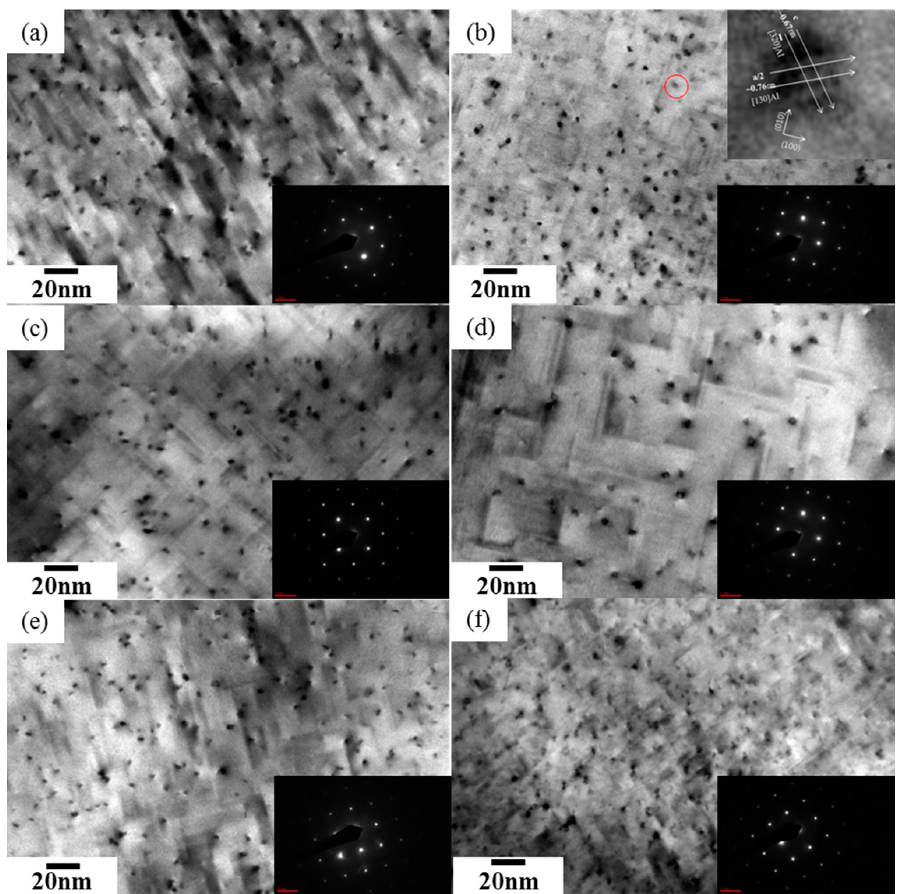
Figure 6. TEM micrographs with different heat treatments in 3M10S and 9M10S. ( a ) AA, ( c ) NA-AA, and ( e ) PA-NA-AA in 3M10S; and ( b ) AA, ( d ) NA-AA, and ( f ) PA-NA-AA in 9M10S. NA, PA, and AA stand natural aging at room temperature for 7 days, pre-aging at 100 ◦ C for 3600 s, and artificial aging at 170 ◦ C for 43,200 s (12 h), respectively. The precipitate is identified as the β ” phase based on structure analysis as shown in upper right of ( b